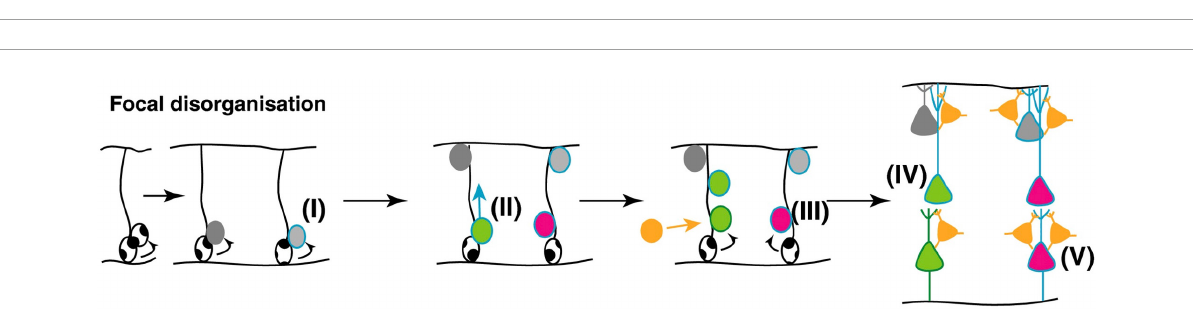
FIGURE9 Potential mechanisms underlying focal disorganization and altered minicolumn distribution in ASD cortex. Focal disruptions may be the result of a combination of early genetic, epigenetic changes or environmental changes affecting neural stem and progenitor cell such that the resulting neuronal progenitors have defects in (I) differentiation (II) or migration (III) causing them to adopt the wrong fate (IV) , or end up in an in appropriate position in the brain (V) . The end result is a cortex with apparent disorganization of neuronal cell types and distorted cell densities. Figure adapted from Donovan and Basson (2017), obtained by Elsevier (No. 5410821023270) under a creative commons license